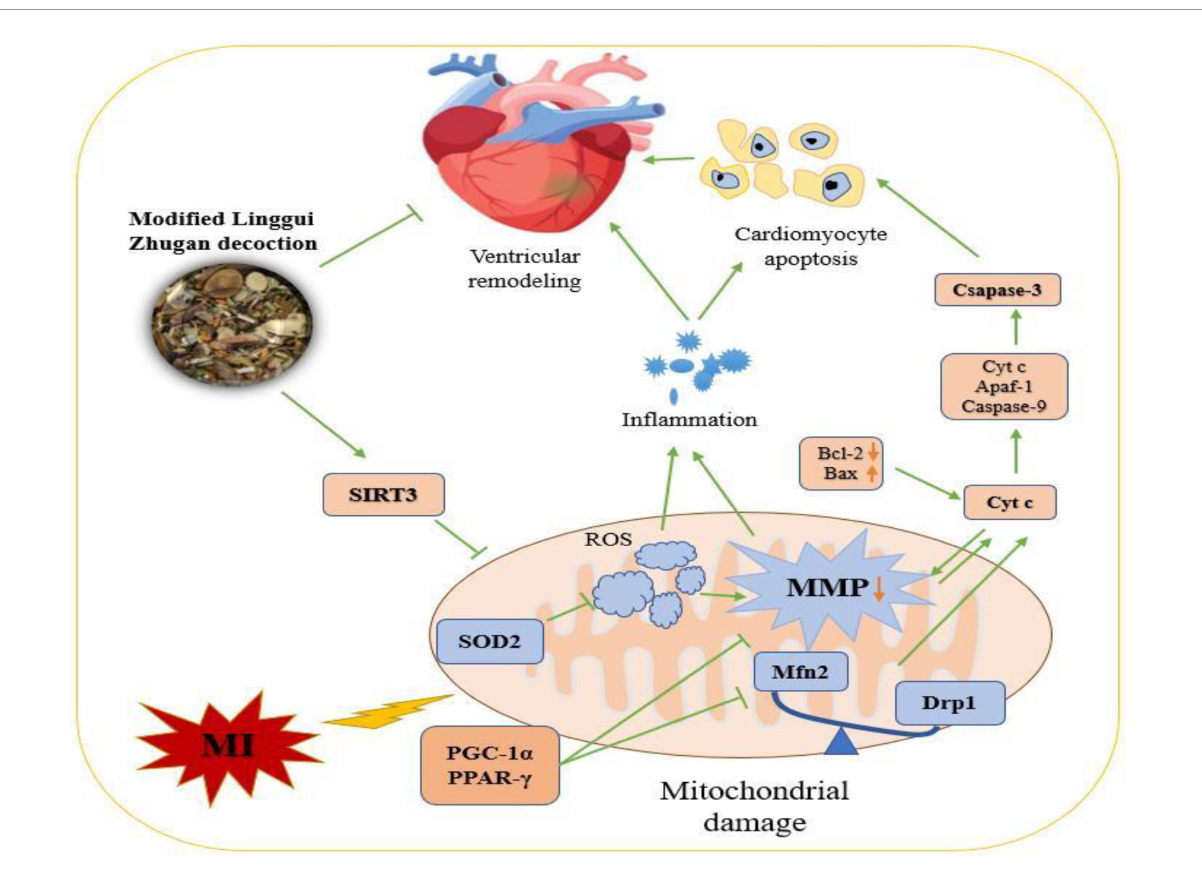
FIGURE10 The mechanisms of Modified Linggui Zhugan Decoction (MLZD) in ventricular remodeling of left anterior descending coronary artery ligation-induced myocardial infarction models. Modified Linggui Zhugan Decoction (MLZD) intervention could exert protective effects on mitochondria, including enhancing mitochondrial antioxidant capacity, regulating mitochondrial dynamics disorder, and inhibiting mitochondrial membrane potential collapse, which contributed to preventing mitochondrial-mediated cardiomyocyte apoptosis. The heart-protective effect of MLZD might associate with SIRT3 activation in the cardiac tissue. MI, myocardial infarction; MMP, mitochondrial membrane potential; SIRT3, sirtuin 3; SOD2, superoxide dismutase 2; ROS, reactive oxygen species; Mfn2, mitofusin2; Drp1,